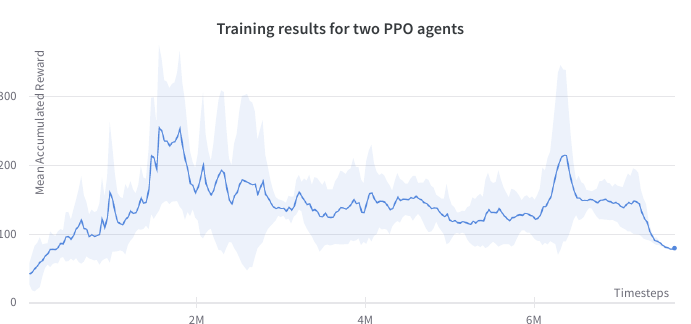
Figure 7. Progression of mean accumulated reward for the two PPO agents.Training results are reported for four experiments with different random seeds. The standard deviation of four runs is shown in the plot.